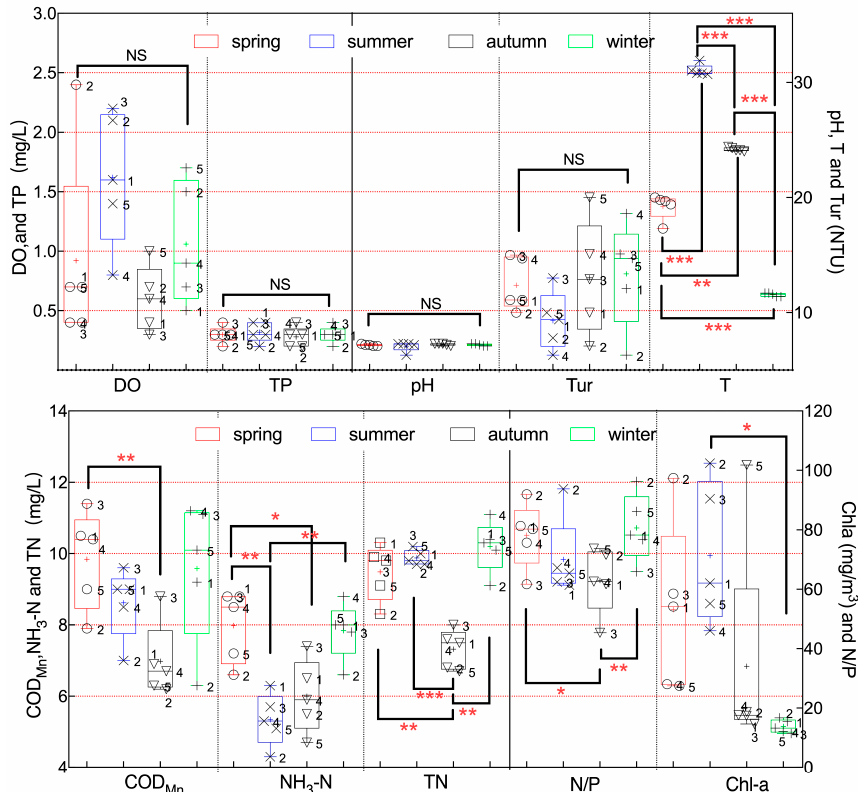
Figure 2. The monitored water quality characteristics of the studied rivers. Note: the numbers of 1–5 in the graph refer to the sampling sites (1: G1, 2: G2, 3: G3, 4: G4, 5: G5). The indexes of DO, TP, COD Mn , NH 3 -N, and TN were expressed with the left axis, and the indexes of pH, Tur, T, Chl-a, and N / P were expressed with right axis. Statistical significance was determined using the repeated-measures ANOVA model for water quality indexes. *: p < 0.05; **: p < 0.01; ***: p < 0.001. NS—not significant.